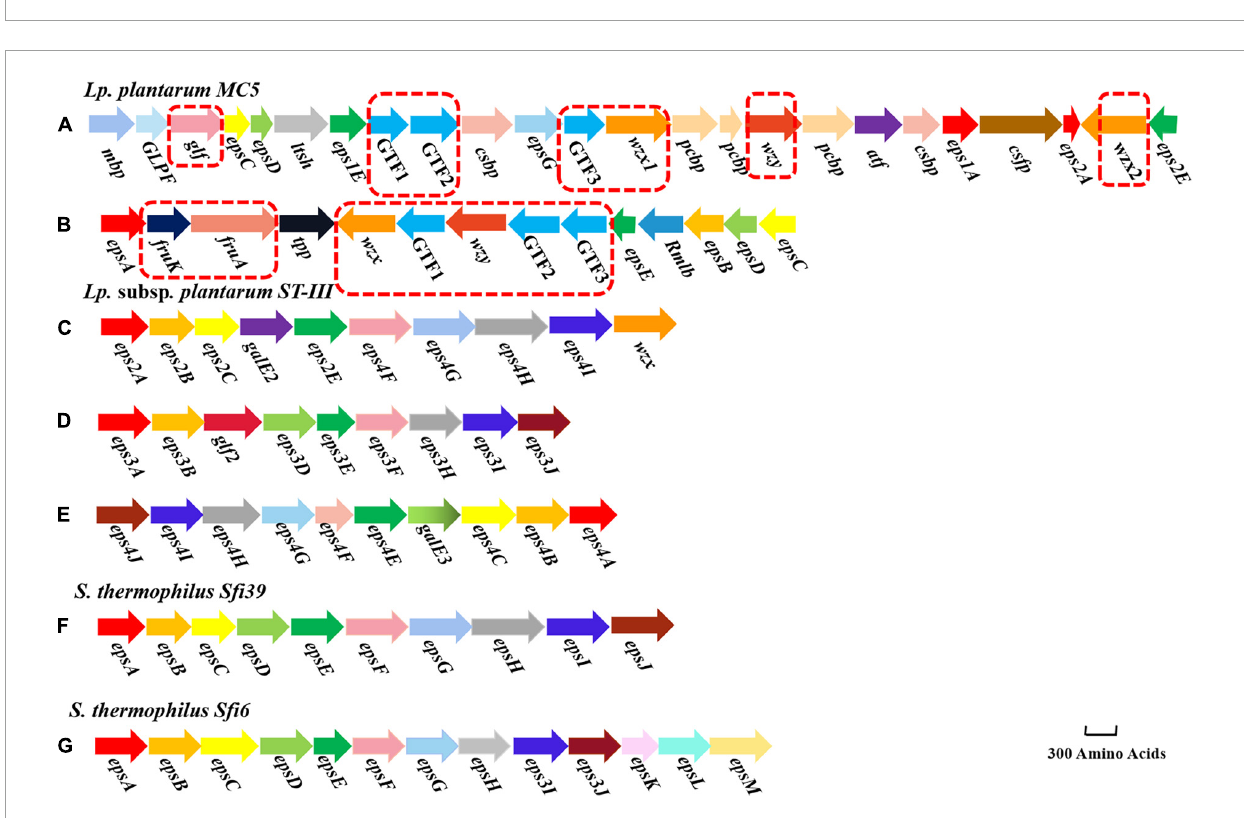
FIGURE7 Structure of the eps gene clusters of Lp. plantarum MC5 ( A : eps cluster 1, B : eps cluster 2), Lp. plantarum subsp. plantarum ST-III ( C : eps cluster 1, D : eps cluster 2, and E : eps cluster 3), S. salivarius subsp. thermophilus Sfi39 ( F : eps cluster 1), and S. salivarius subsp. thermophilus Sfi6 ( G : eps cluster 1). Different colors indicate the different functions of genes. Genes in red dashed boxes are MC5-specific genes.